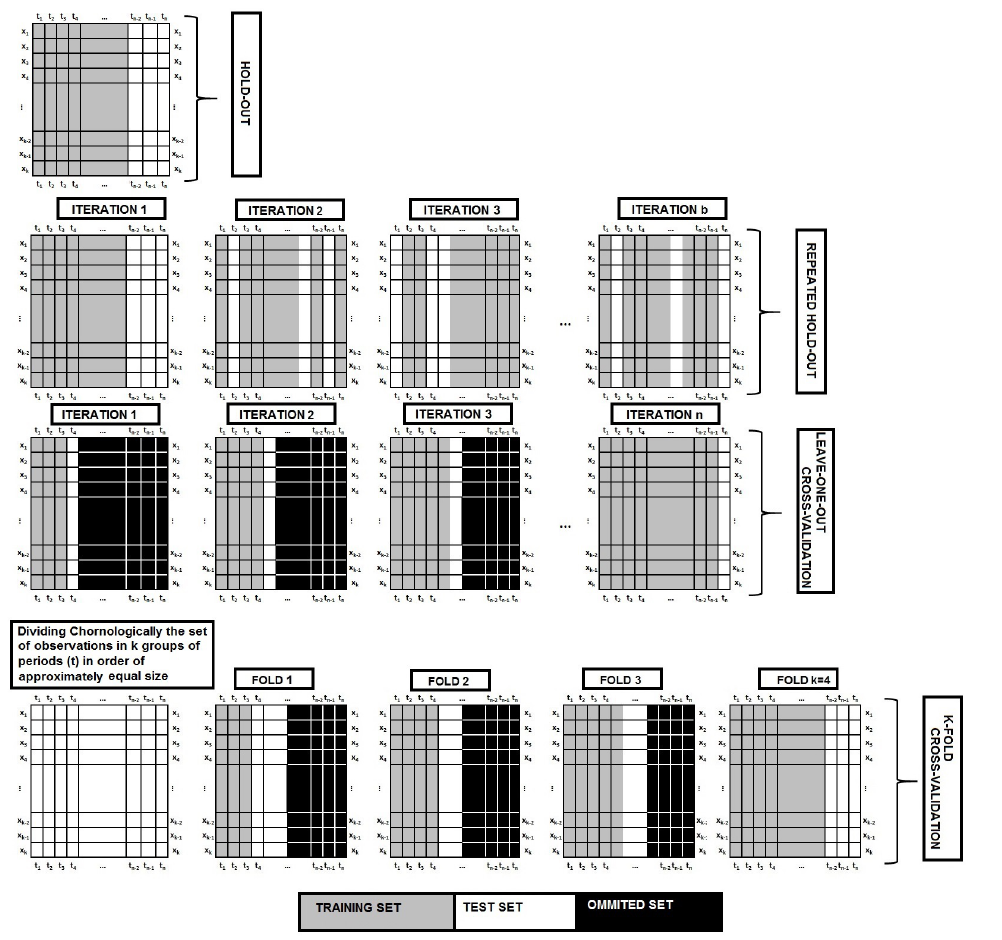
Figure 1. A schematic display of the employed resampling methods for an embedded time series. The training set, validation set and omitted set are shown in gray, white and black,